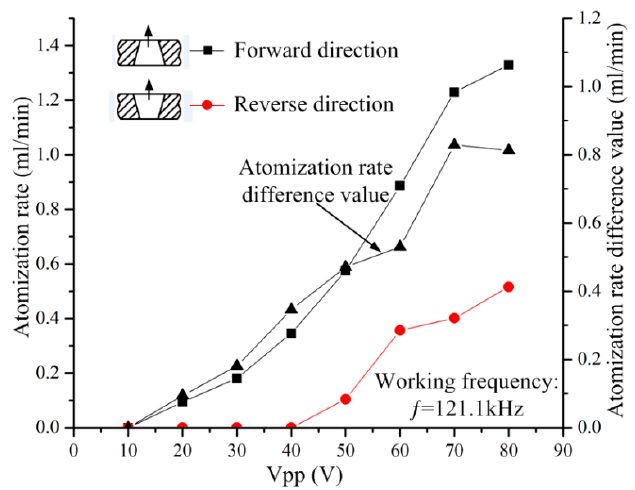
Figure 8. Variation in the atomization rate and the atomization rate and differences with applied voltage when the micro-tapered aperture atomizer is operating in the forward and reverse directions.